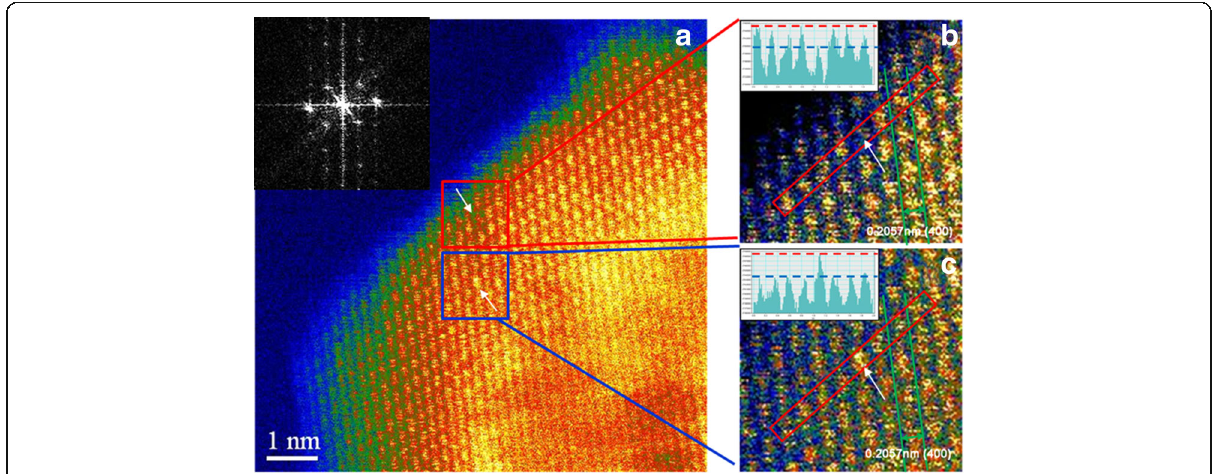
Fig. 3 HR-STEM images of Ti-doped nano MgAl 2 O 4 ; a . The image shows Al 3+ vacancy and Ti 4+ dopant in the vicinity with Fourier transformation of the image. b The magnified image in red box of ( a ) and Al 3+ vacancy is revealed from STEM image with a corresponding contrast intensity, inset of ( b ). c The contrast intensity, inset of ( c ), confirms that Ti 4+ dopant occupies an Al site. The arrows indicate the locations of Al vacancy and Ti in Al site,